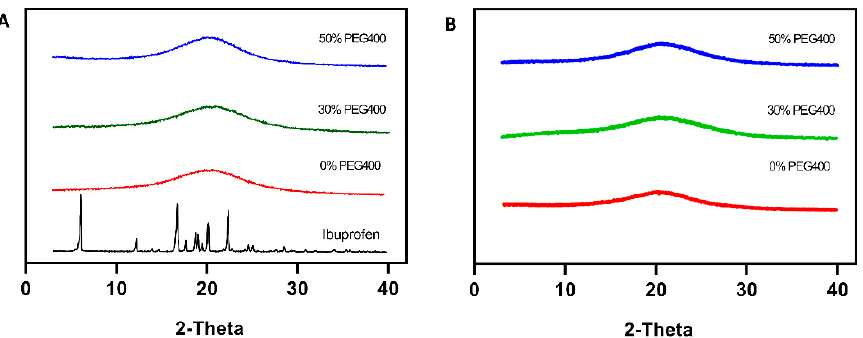
Figure 6. ( A ) X-ray powder diffractograms of the pure drug and printed pellets. ( B ) X-ray powder diffractograms of the printed pellets after the stability tests.